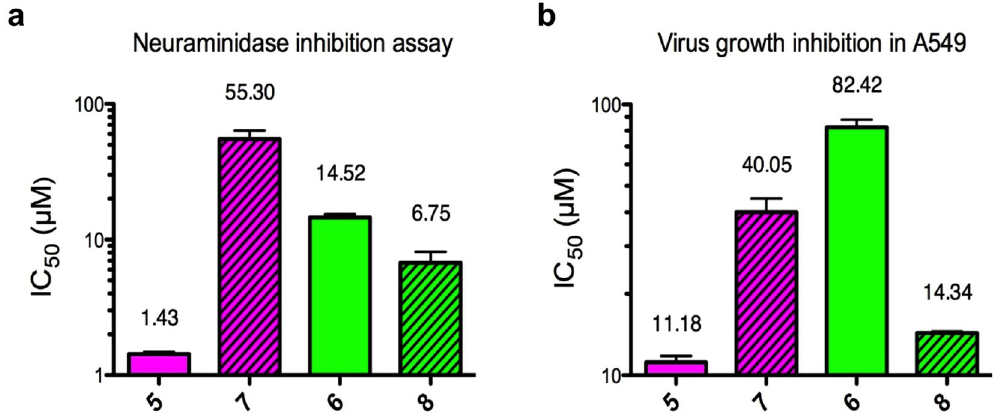
Figure 4. Biological evaluation of the 2,3-difluoro inhibitors in relation to their Neu2en analogues. ( a ) Inhibitors 5 , 6 , 7 , and 8 were evaluated in a neuraminidase assay. These values are the means of determinations from 3 independent experiments performed in duplicates and error bars correspond to calculated standard deviations. ( b ) Virus growth inhibition was determined by an in situ ELISA technique using the human cell line A549. IC 50 values of 11.2 ± 0.9 µ M, 40.1 ± 7.0 µ M, 82.4 ± 7.7 µ M and 14.3 ± 0.3 µ M were determined for 5 , 7 , 6 and 8 , respectively. These values were evaluated from at least 2 independent experiments performed in triplicate and error bars correspond to the calculated standard